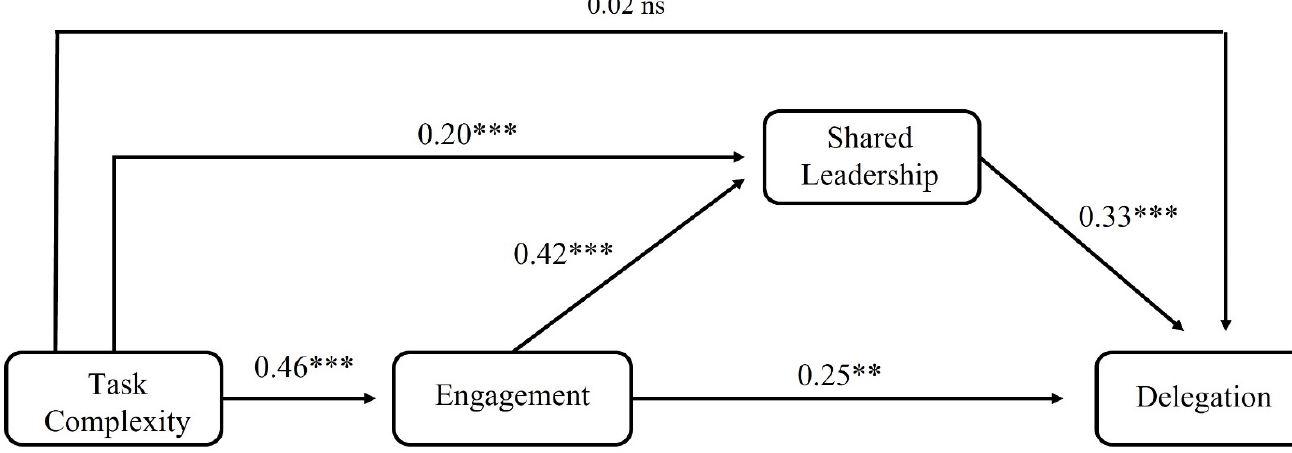
Figure 2. Model 1. Notes: ns = no significant; ** p < 0.01; *** p < 0.001 . Table 7. Indirect effects of model 1